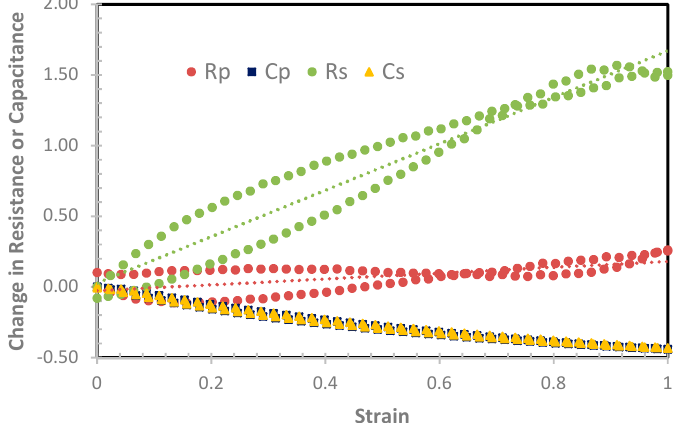
Figure 7. The change in R S , R P , C S , and C P versus strain of the IDC sensors made from 40 wt% 200 nm BTO. The measured capacitance of the IDC sandwiched between different substrates at 0% strain is